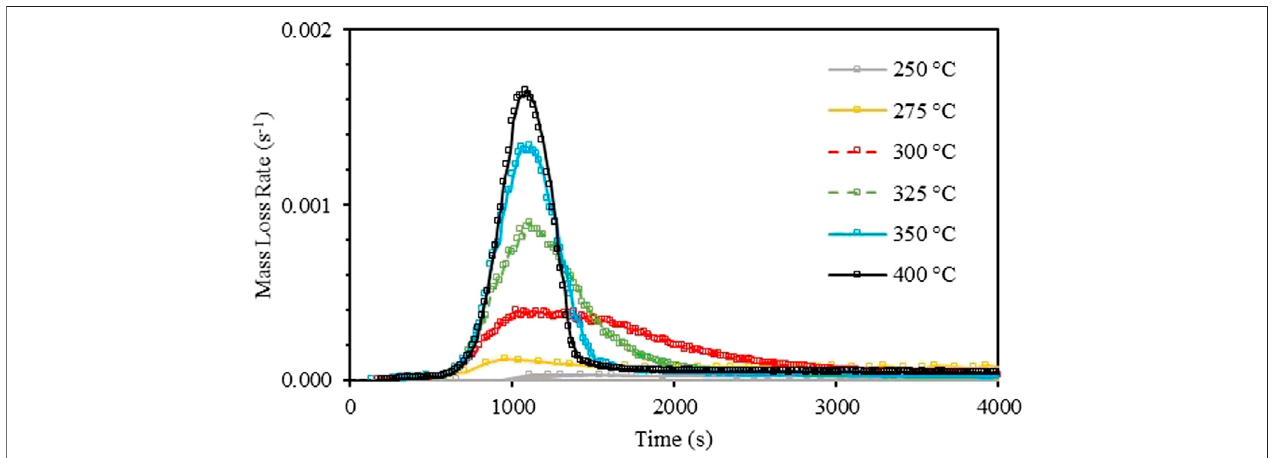
FIGURE 1 | Measured mass loss rate at different temperatures vs. time.